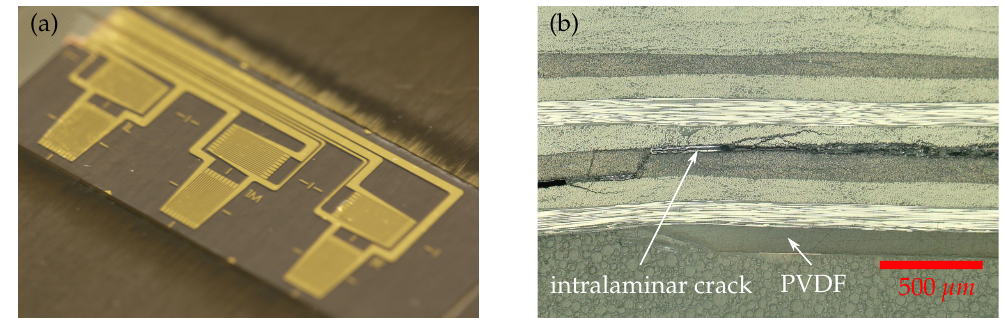
Figure 11. ( a ) Thin-film sensors co-cured to a CFRP-adherend. ( b ) Cross section sample of ruptured CLS strap with interlaminar crack propagation. Sample was gained from a CLS specimen with integrated MDAF that was pulled until a complete failure of the bondline was achieved.